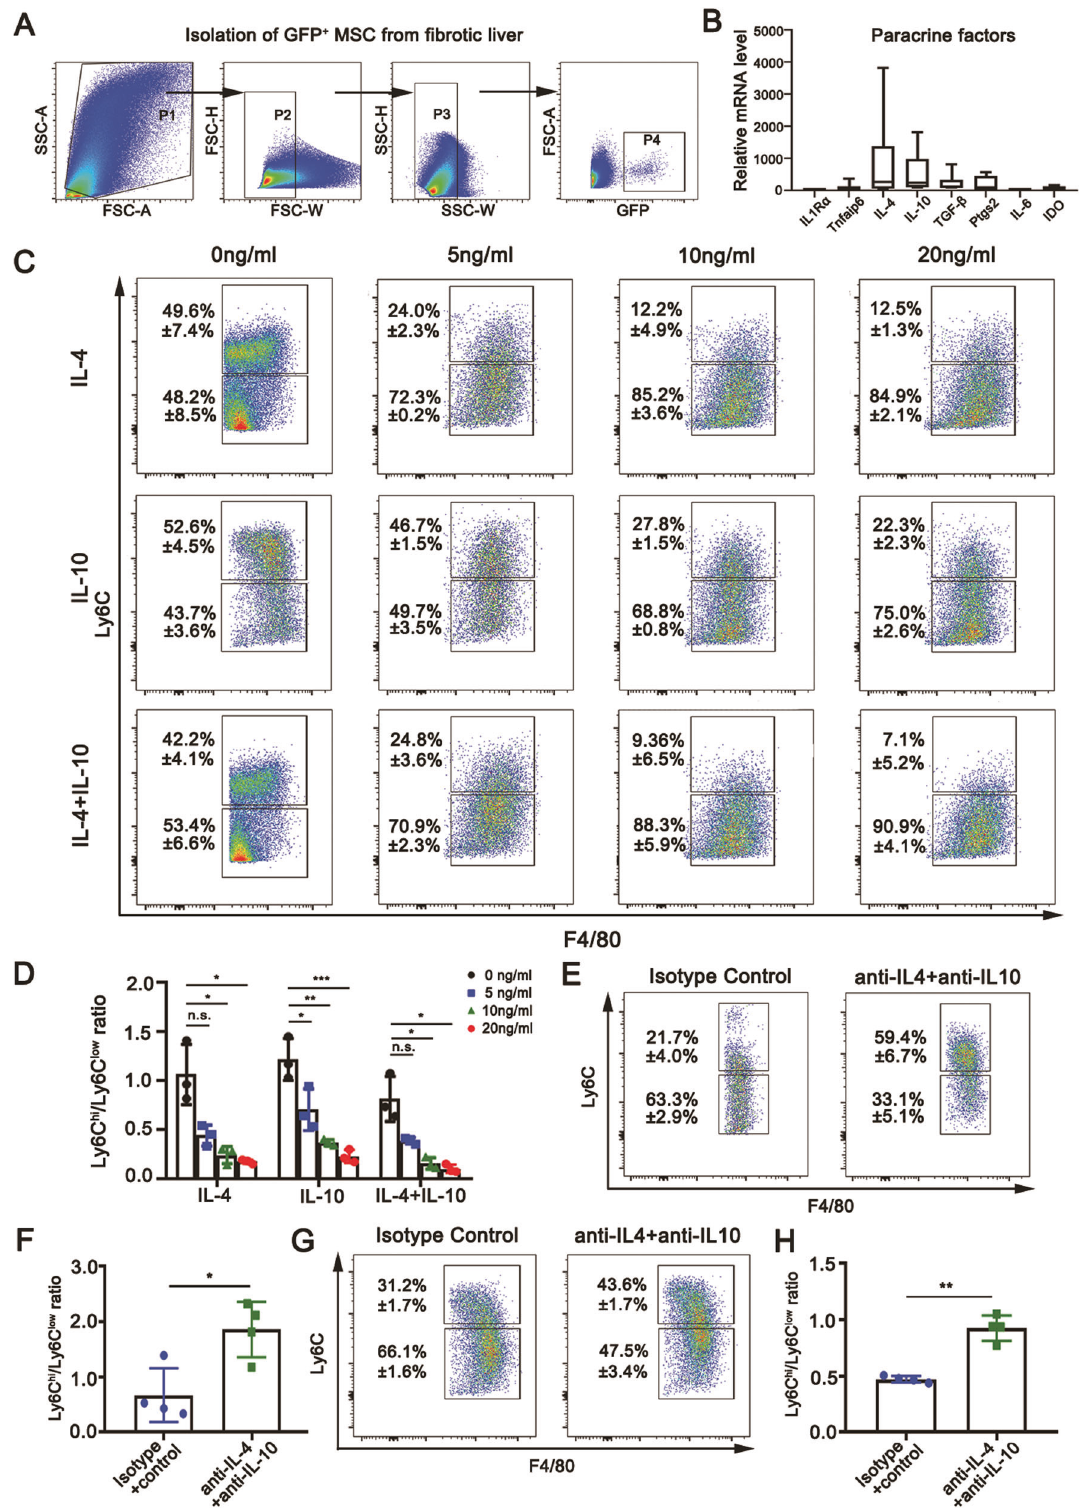
apoptotic cell death after transplantation. For clari fi cation, an in vivo activation assay for apoptotic caspase-3 was examined in Luc + BM-MSCs. In this case, the activation of caspase-3 was detected as luciferase activity by the administration of Z-DEVD- aminoluciferin. As expected, remarkable luminescence